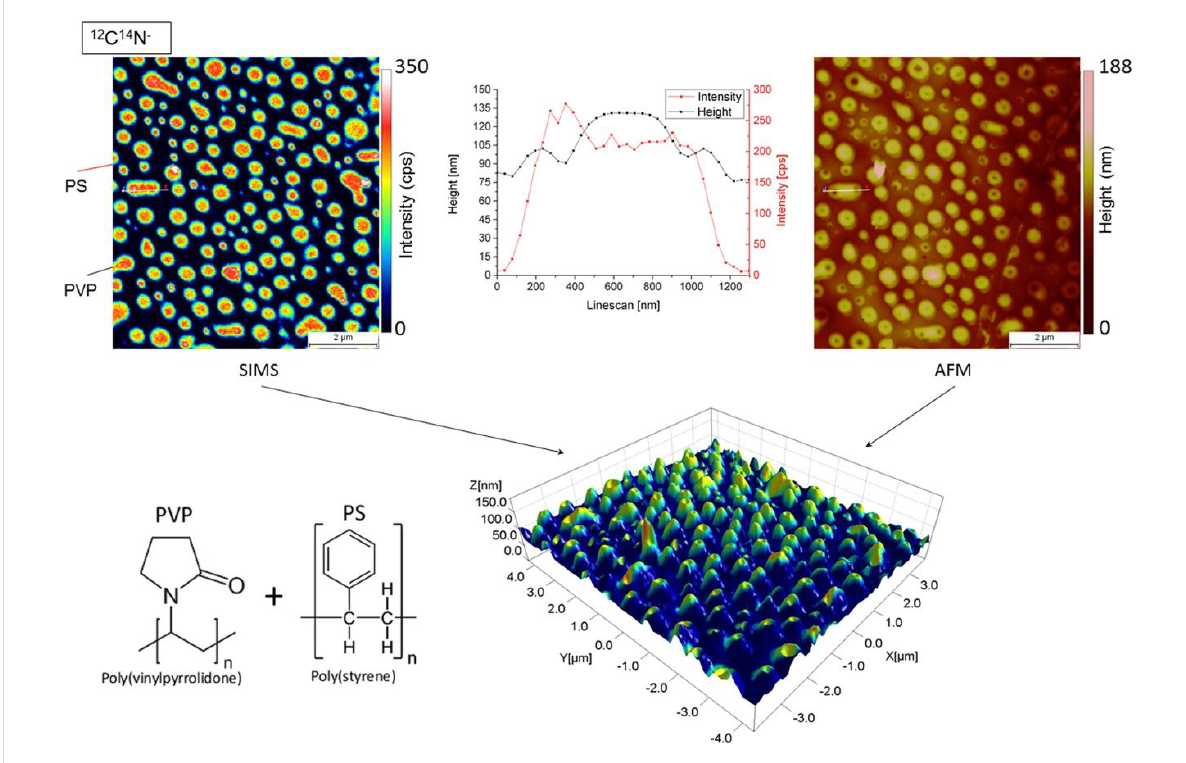
Figure 1: PVP/PS polymer blend after Cs + bombardment of 1.02 × 10 16 ions/cm 2 : The SIMS recorded secondary ion intensity and the AFM recorded topography of the area of interest are superposed and compiled into a 3D surface mapping.